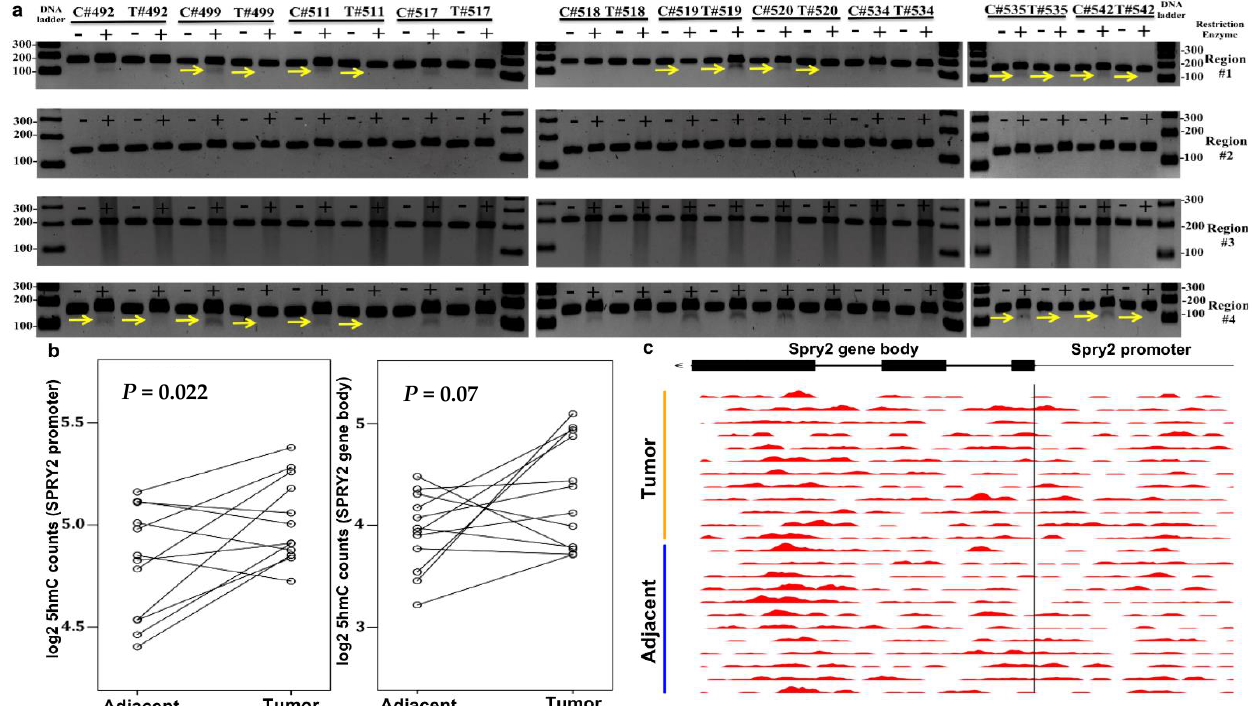
Figure 3. ( a ) Combined bisulfite restriction assay (COBRA) results of 4 regions of interest located in SPRY2 from 10 colorectal cancer (CRC) patients (T(tumor)# patient ID number) and adjacent normal colonocytes (C(control)# patient ID number). Each sample was run on two lanes: lane 1) bisulfite-treated PCR amplified DNA without restriction enzyme digestion, which served as a reference control for unmethylated CpG and lane 2) bisulfite-treated PCR amplified DNA digested with a restriction enzyme recognizing amplicons containing a 5′ mCpG sequence. + Lane: PCR product treated with restriction enzyme lane, − Lane: PCR product from untreated sample. Yellow arrows serve to highlight differential methylation between matched control and tumor samples for a given patient, where a visible band underneath the PCR product indicates the presence of 5mC and no visible band indicates no 5mC presence. ( b , c ) 5-hydroxymethylcytosine (5hmC) abundance in SPRY2 gene bodies in colon cancers and matched adjacent mucosa ( n = 12 samples, p < 0.05, paired Student’s t-test): ( b ) Increase in mean log2 fold change of 5hmC in SPRY2 gene promoter and a marginal increase in the gene body in colon tumors (Tumor) compared to normal colon (Adjacent). ( c ) 5hmC peaks within the gene bodies of SPRY2 in tumor and normal colon. The moving averages at 0.01 smoother span are shown. Black bars mark exons.